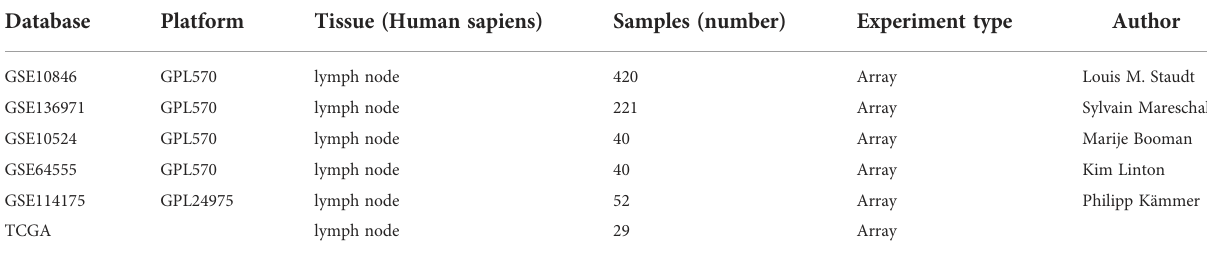
TABLE 1 The survey of